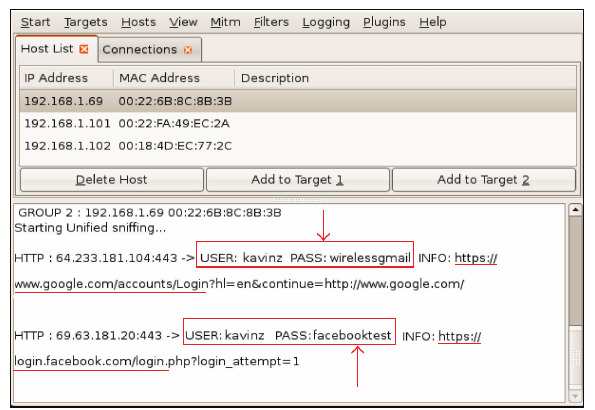
Figure 14: Exposing bank account information by the MITM